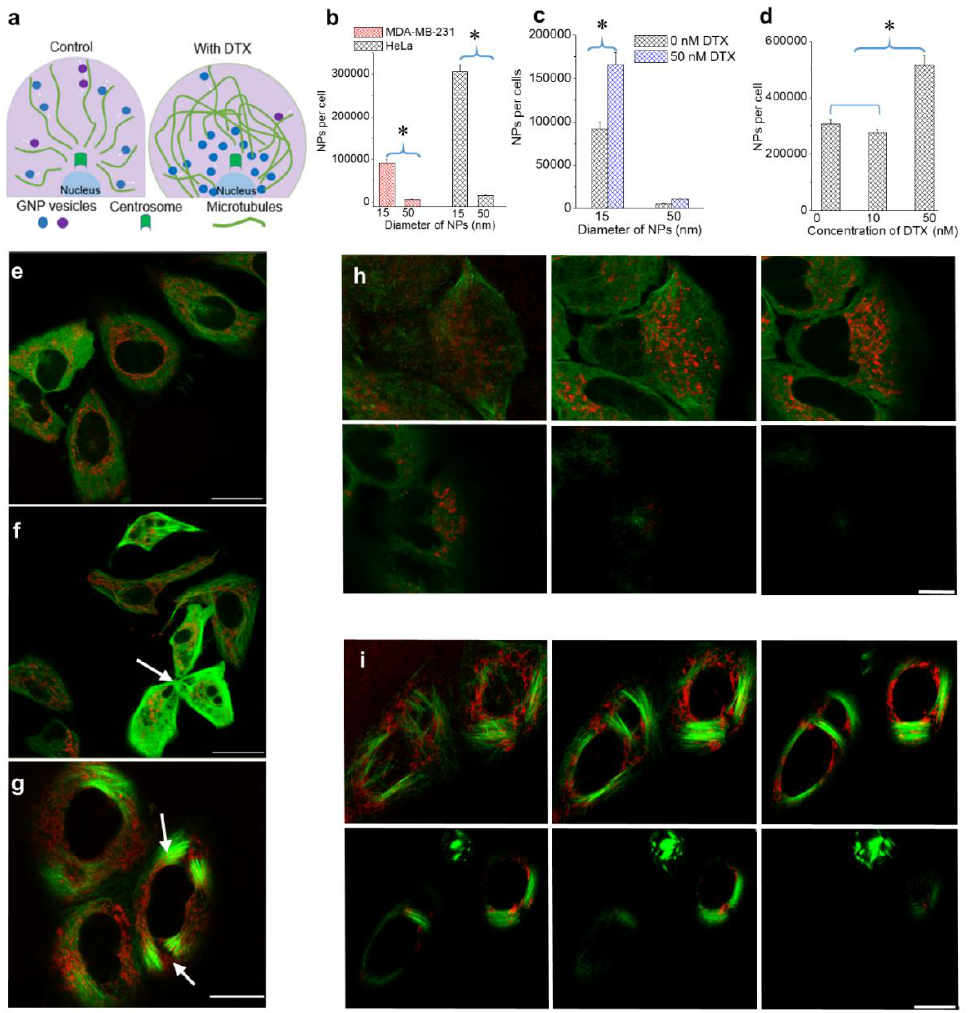
Figure 2. The e ff ect of NP size and DTX concentration on intracellular NP accumulation. ( a ) Schematic diagram highlighting di ff erences in the MT network and NP distribution in the absence and presence of DTX. ( b ) Size-dependent uptake of NPs in MDA-MB-231 and HeLa cells. ( c ) Size-dependent uptake of NPs in the presence of a 50 nm DTX concentration in MDA-MB-231 cells. ( d ) DTX concentration dependent NP uptake in MDA-MB-231 and HeLa cells. ( e – g ) Images showing NPs and the MT network in cells treated with 0, 10, and 50 nM of DTX, respectively ( f ): arrow indicates cell fragmentation during division; g: arrows indicate bundling of MTs). ( h – i ) Z-stack showing the distribution of NPs and the MT network in a group of cells treated with 0 and 50 nM DTX, respectively. Vesicles containing GNPs and MTs are marked in red and green, respectively. Scale bar is 20 µ m. Error bars are standard deviations from 3 replicate measurements. * Represents a statistically significant di ff erence (Welch’s unequal variance t -test, p < 0.05).